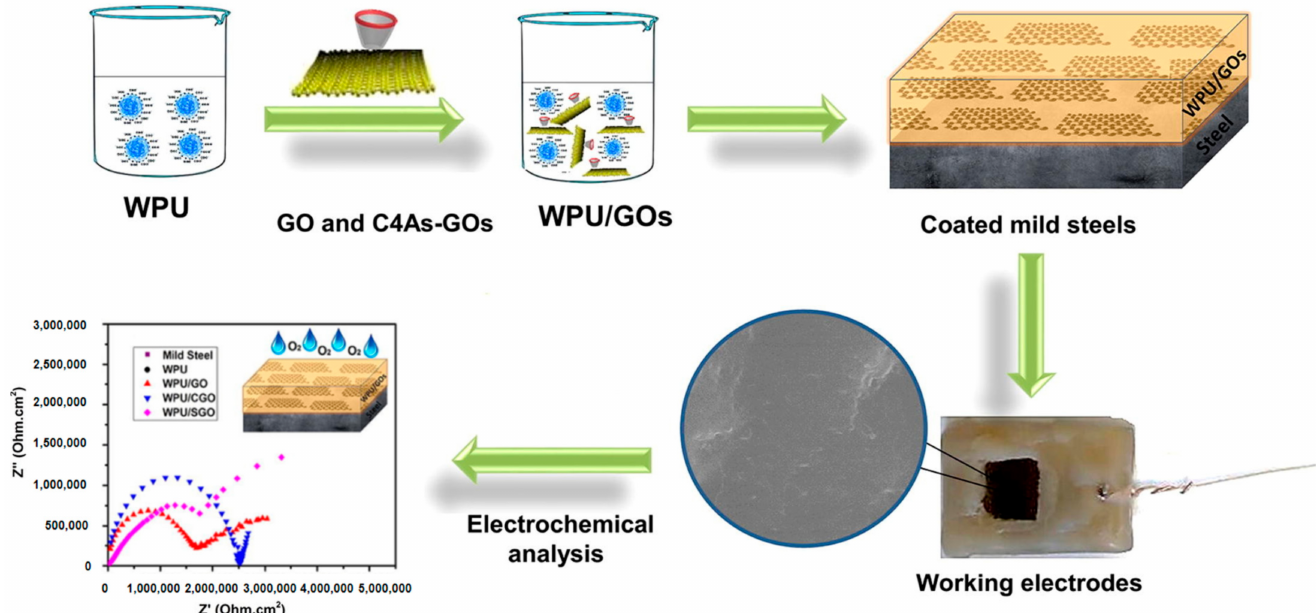
Figure 9. Schematic diagram of specific process. Reprinted with permission from